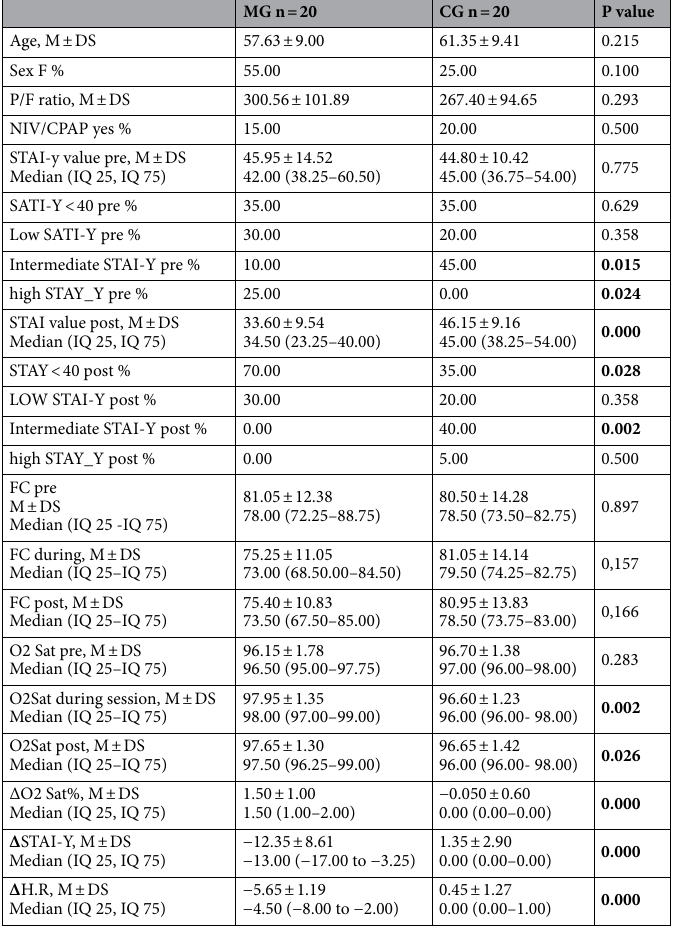
Table 1. Comparison of music therapy group (MG) versus control group (CG). P/F ratio PaO2/FiO2, STAI-y STAI-y: State-Trait Anxiety Inventory—y form, H.R . heart rate, O2Sat oxyhemoglobin saturation, Δ O2 Sat% difference between the value of O2 Sat calculated at time T2 minus the value of O2 Sat at time T0, TO time at the start of the session, T1 time during the session, T2 time at the end of the session, ΔH.R . difference between the value of O2 Sat calculated at time T2 minus the value of O2 Sat at time T0, Δ STAI-Y difference between the value of STAI-Y calculated at time T2 minus the value of STAI-Y calculated at time T0. Significance was assumed for p values <